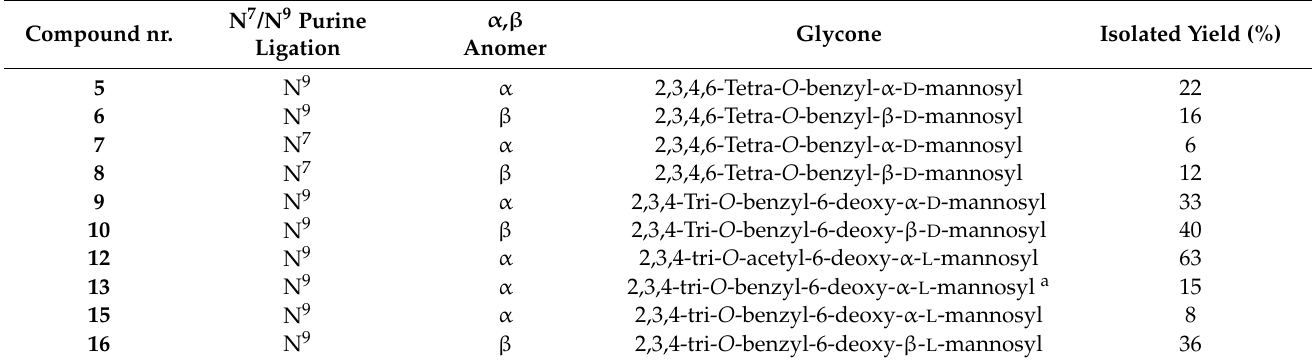
Table 1. Isolated yield and structural features of the new synthesized and tested purine nucleosides, accessed by microwave-assisted reaction of the methyl glycoside precursors with N -(9 H -purin-6- yl)benzamide (150 W, 65 °C, 1 h).